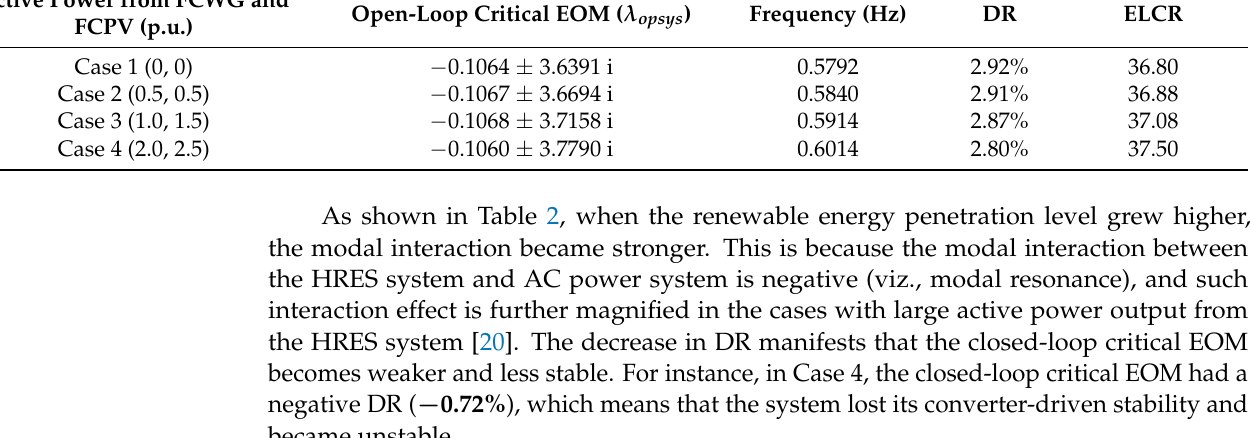
Table 1. Open-loop modal analysis regarding different renewable energy penetration levels. Active Power from FCWG and FCPV (p.u.)